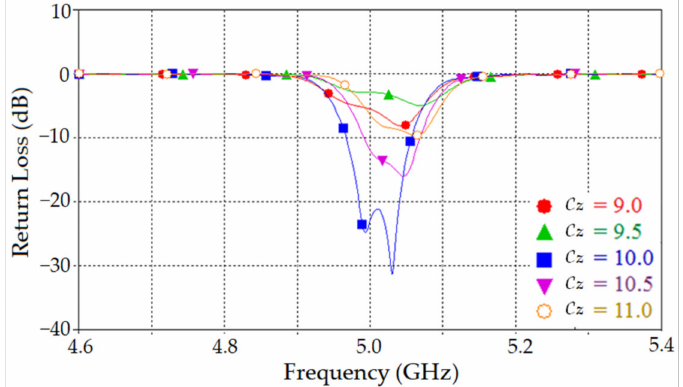
Figure 8. Simulated return loss for different values of ‘ c z ’.